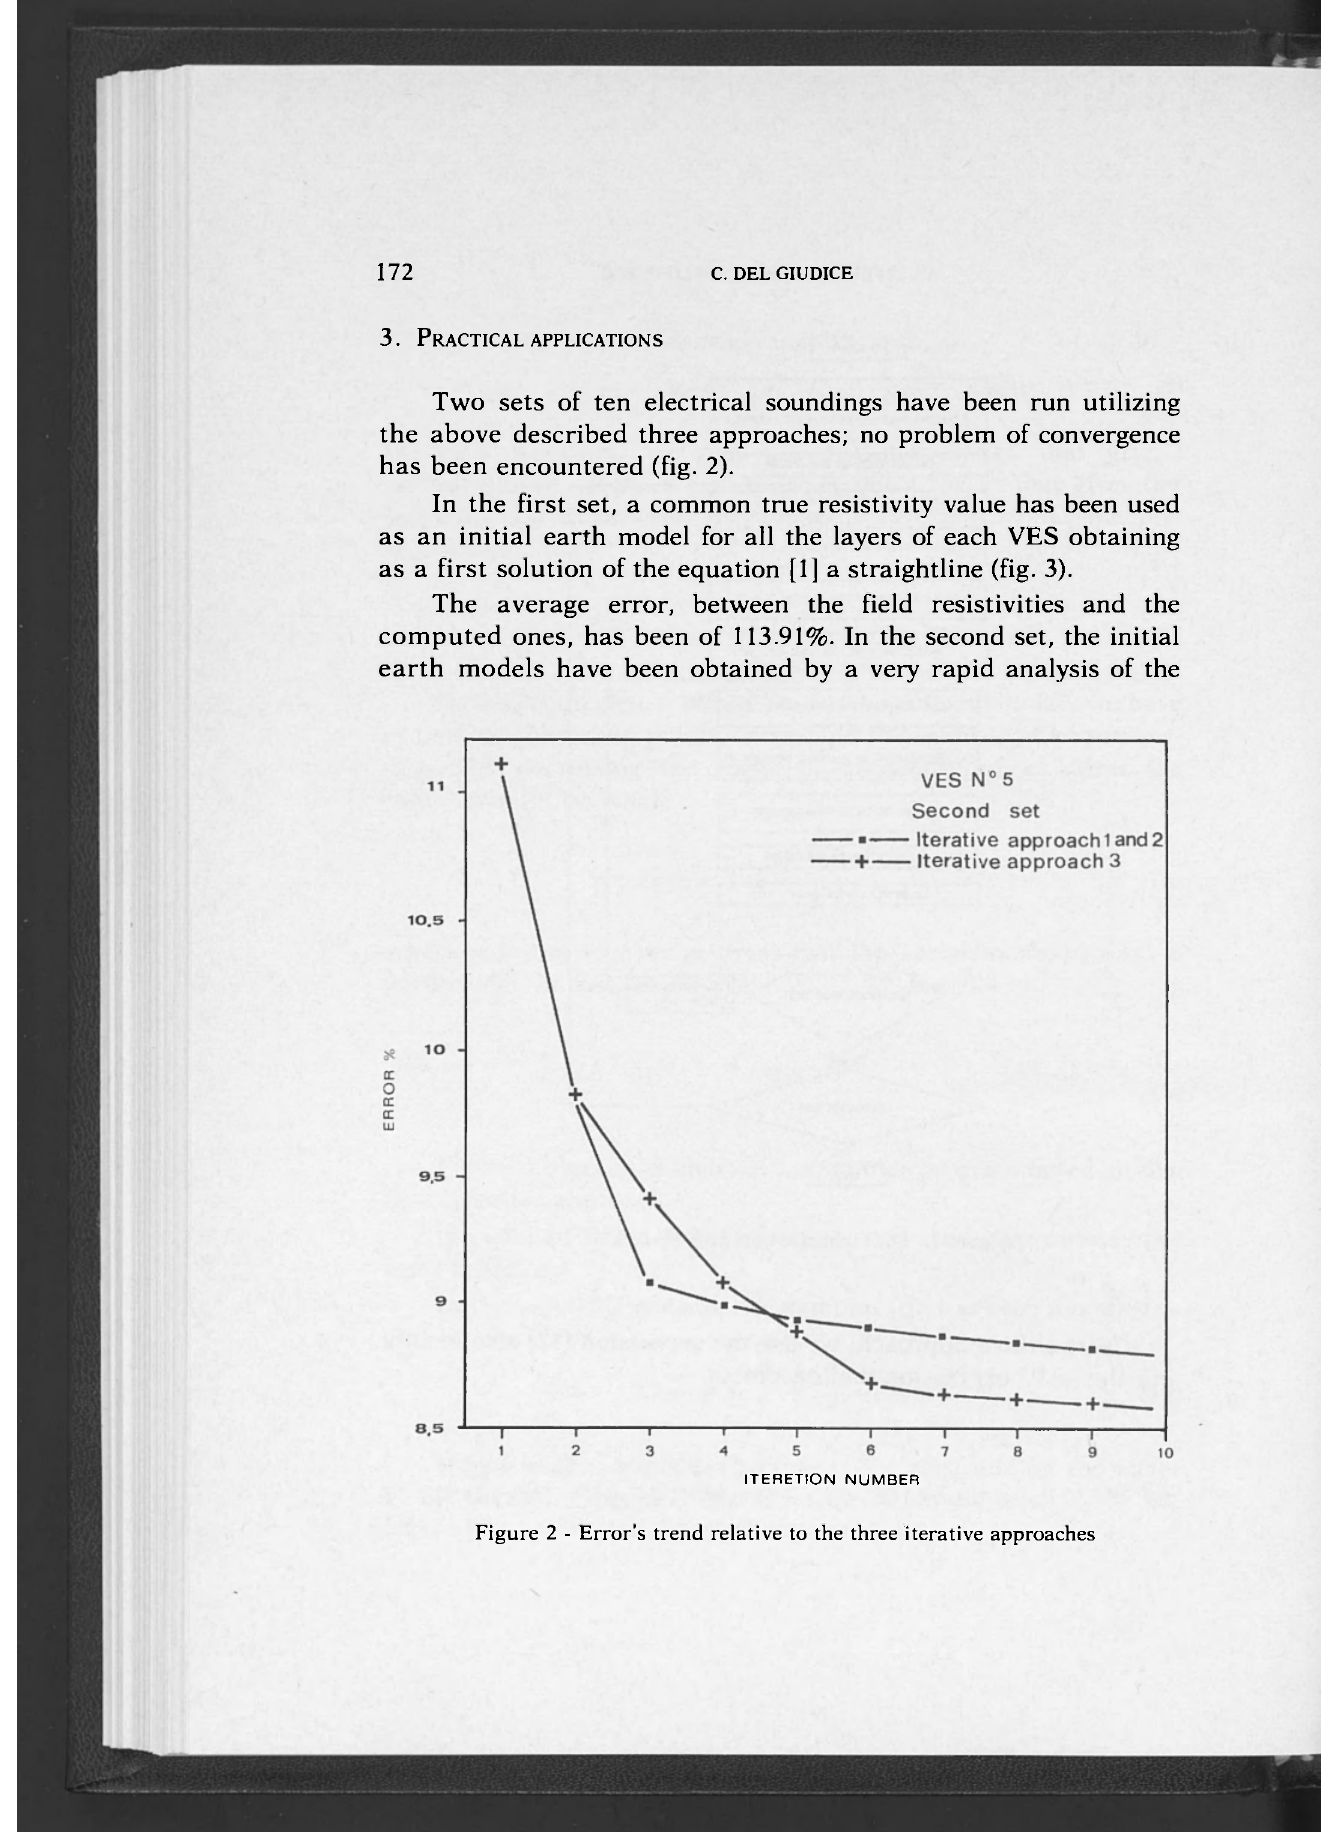
Figure 2 - Error's trend relative to the three iterative